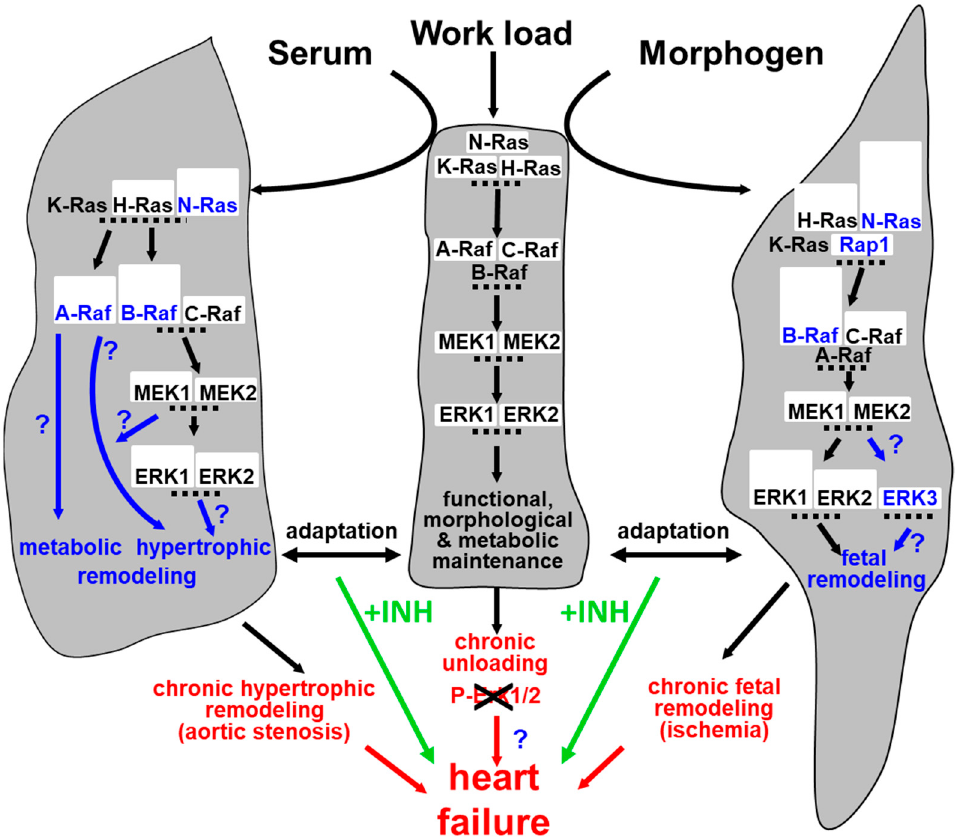
Figure 7. Remodeling of the MAPK pathway in the hypothetical context of cardiac adaptation and failure. The myocardium has a certain capacity to adapt to increased load either by hypertrophy (e.g., evoked though aortic stenosis) or by fetal remodeling (e.g., evoked through ischemia). However, when cardiac demands are not met and become chronic, heart failure may develop. Cardiomyocyte remodeling does not only result in structural reorganization but also involves reprogramming of the MAPK. A third road to heart failure might be produced by cardiac unloading due to the absence of appropriate stimuli rendering cardiomyocytes unfunctional. The interference by MAPK inhibitors ( + INH) might disturb adaptive processes and enhance the development of heart